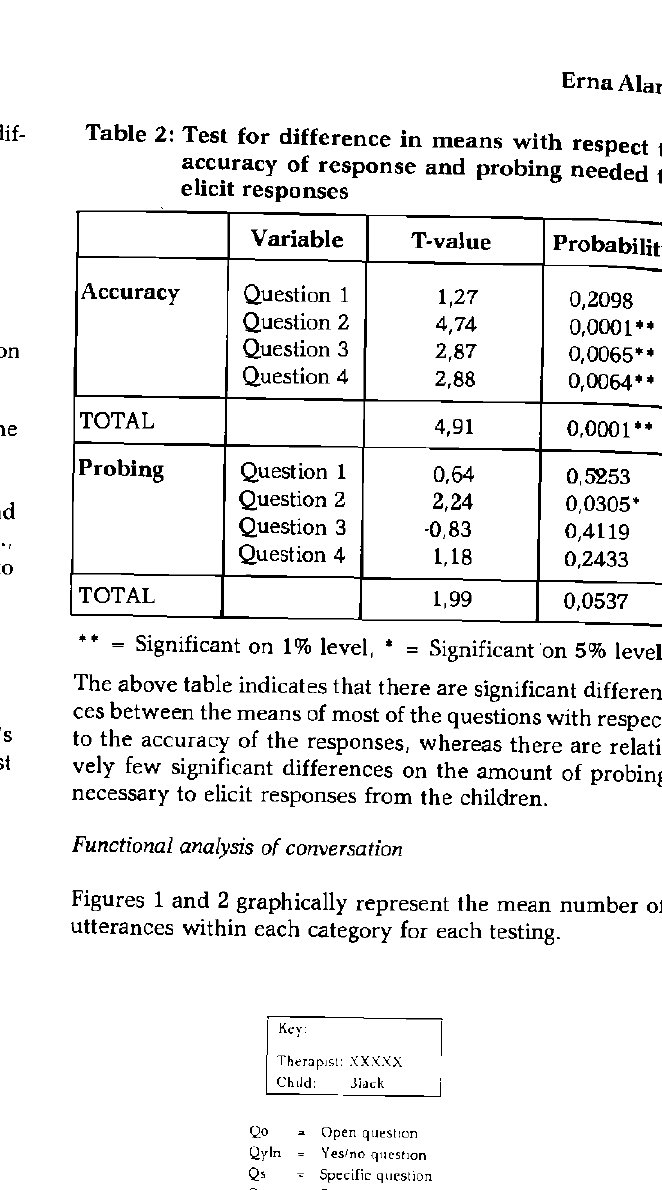
Figure 1: Functional analysis of conversations between therapist and child in 1984